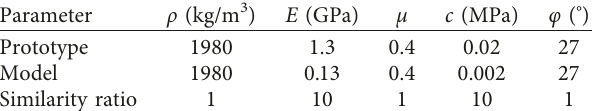
Table 2: Material parameters of prototype and model.